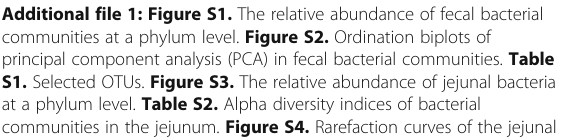
Additional file 1: Figure S1. The relative abundance of fecal bacterial communities at a phylum level. Figure S2. Ordination biplots of principal component analysis (PCA) in fecal bacterial communities. Table S1. Selected OTUs. Figure S3. The relative abundance of jejunal bacteria at a phylum level. Table S2. Alpha diversity indices of bacterial communities in the jejunum. Figure S4. Rarefaction curves of the jejunal